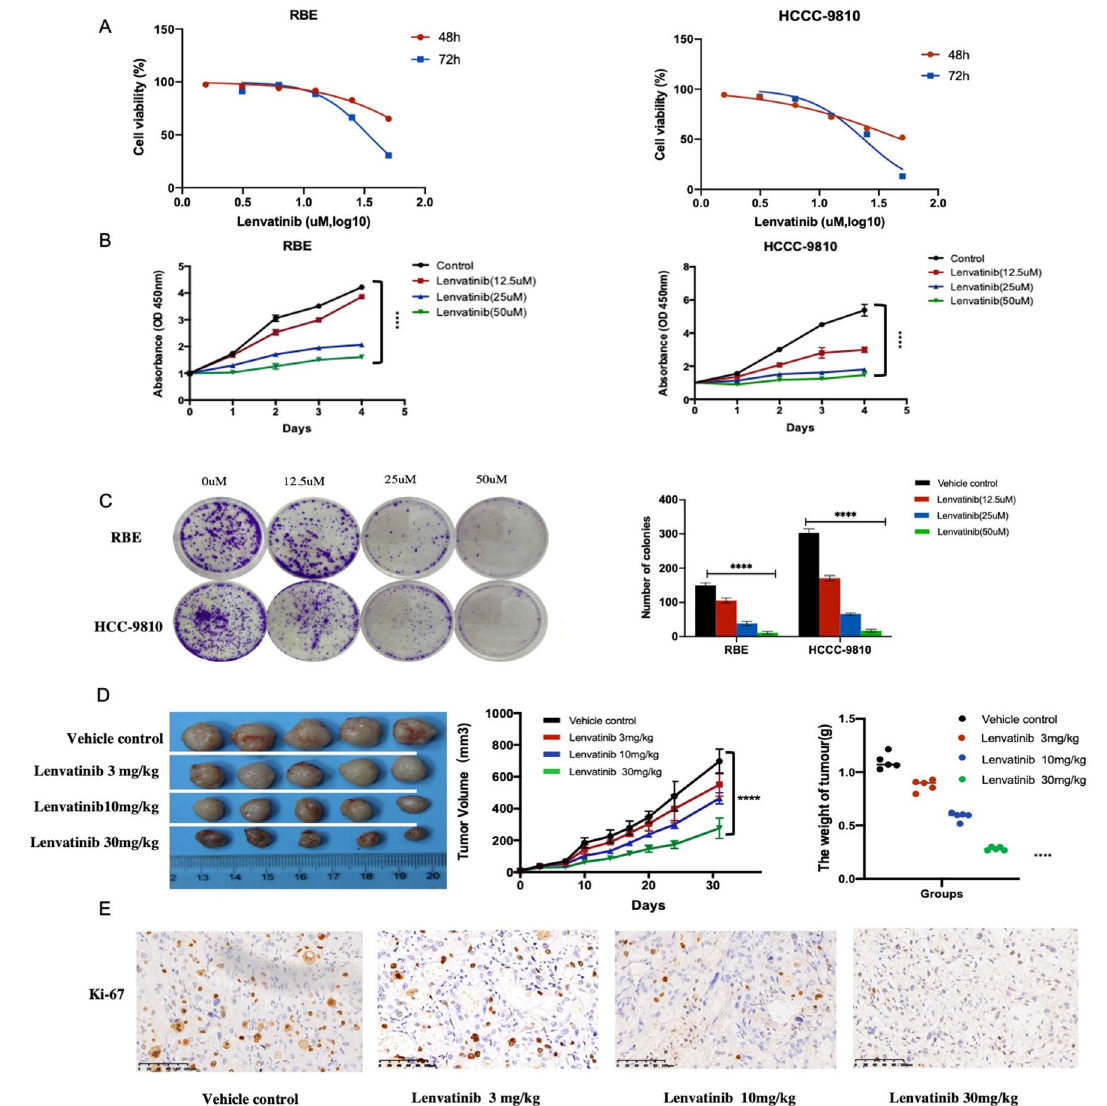
Fig. 2 Lenvatinib inhibits ICC cell growth in vitro. a HCCC-9810 and RBE cells were treated with lenvatinib for 48 and 72 h. Cell viability was measured using CCK-8, and IC50 values were calculated. b CCK-8 assays were used to test the effects of lenvatinib on the viability of ICC cells. c Representative images of colony formation assays. d Tumor growth curves and tumor weights for the CDX model. e The expression of the proliferation marker Ki-67 was determined in tumor tissue sections from the xenografts using IHC (scale bar, 20 μm). * P < 0.05, ** P < 0.01, *** P < 0.001, **** P <